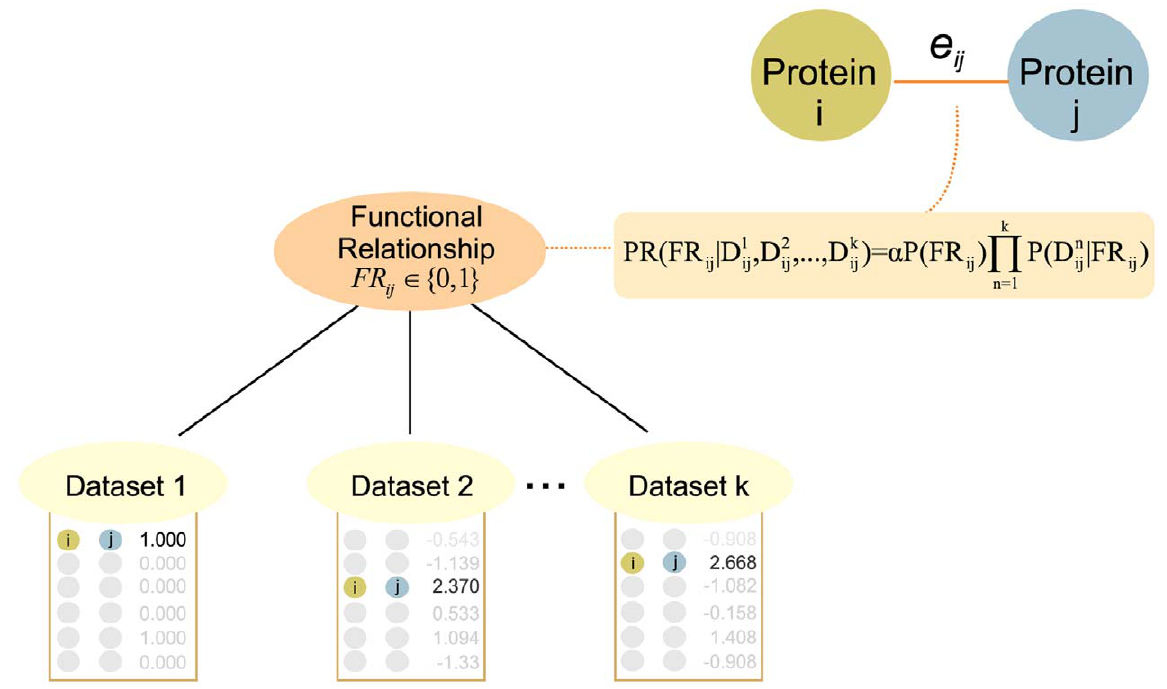
Figure 1 . Naı¨ve Bayesian Networks for Genomic Data Integration. A Bayesian network is a machine learning tool for organizing and encoding statistical dependence relationships among pieces of knowledge. A naı¨ve Bayesian network is a simplified version of a Bayesian network in which all child nodes are dependent on the parent and independent of each other. This type of graphical device may be used to combine different types of evidential data and prior knowledge to generate probabilistic models of biological functional relationship networks. In our naı¨ve Bayes net structure, the functional relationship between the pair of proteins i and j (FR ij ) is a hidden conditional variable (indicating the unknown or hidden probability that these two gene products are functionally associated), on which all dataset evidence variables are dependent, and represents the discretized, observed similarity score in dataset k for proteins i and j . The edge weight (e ij ) represents the probability that the proteins ij are functionally related given the evidence observed in different high-throughput datasets. Strong evidence of a functional relationship between protein pairs, measured by edge weight, indicates the proteins behave in a similar way given observed patterns in the high-throughput data. The specific nature of that relationship can be deduced by evaluating the type of datasets that contribute to that edge weight, followed experimental validation.